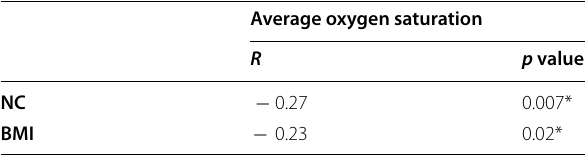
Table 7 Correlation of average oxygen saturation with BMI and neck circumference in COPD patients